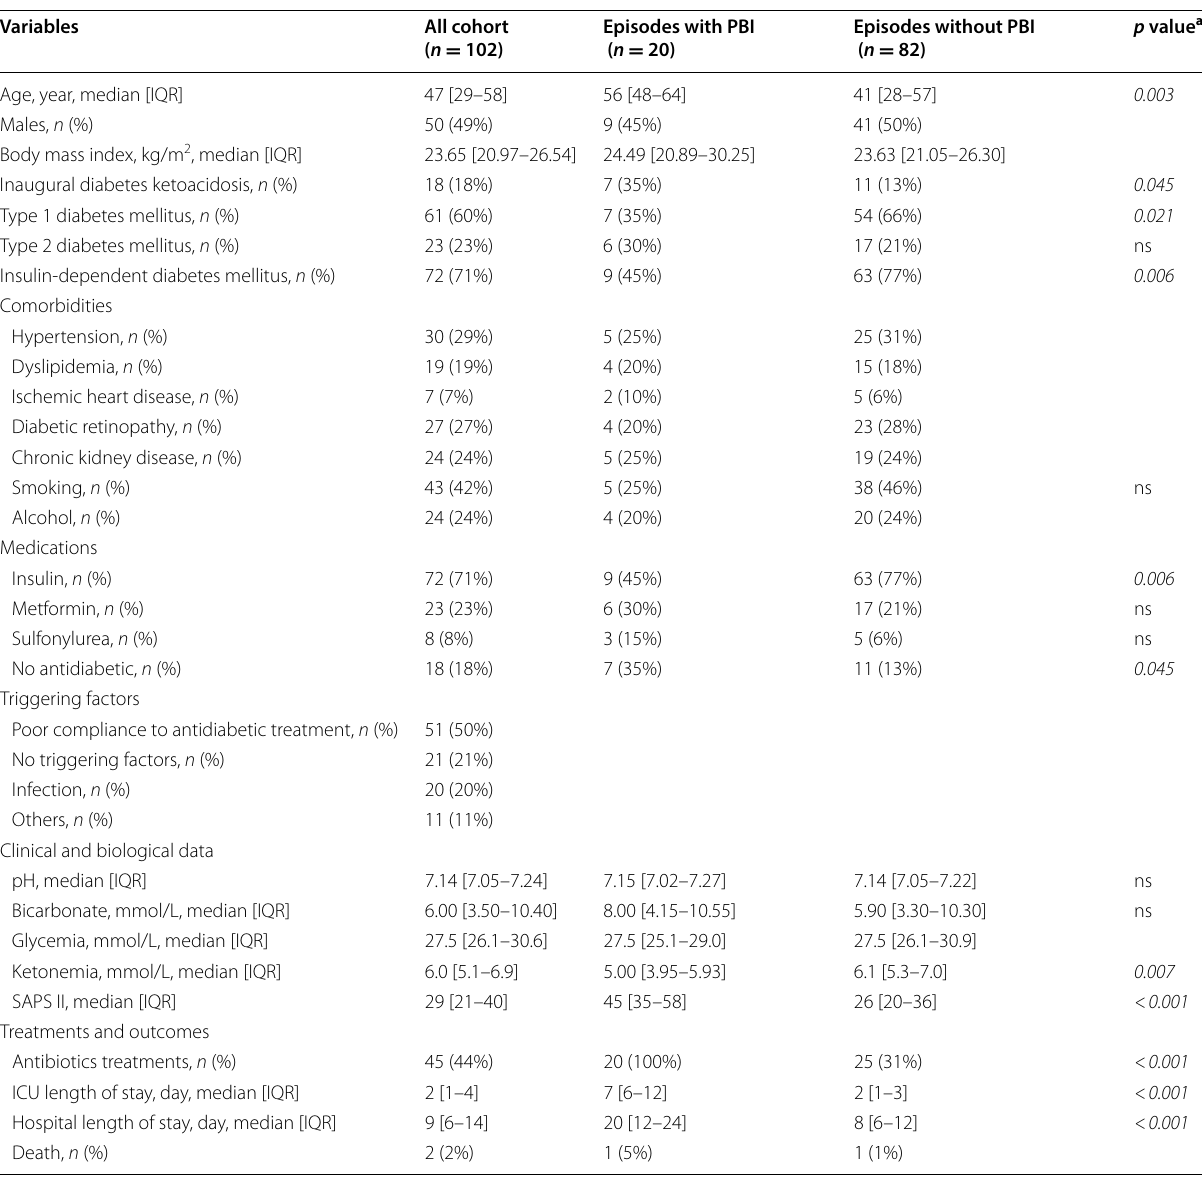
Table 1 Demographic and clinical baseline characteristics of the